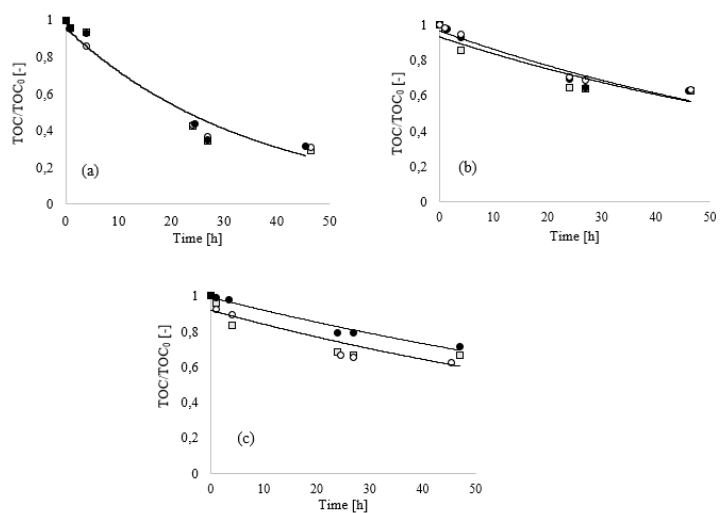
Figure 5. TOC removal trends (Blackman equation) during accelerated biodegradation tests of conditioning mixture A ( a ), B ( b ) and C ( c ) with 2.0 mL of Bacillus Clausii at different operative temperature as 20 °C ( □ ), 30 °C ( ○ ) and 40 °C ( ● ). Conditions: pH = 6 and 0.10% as conditioning mixture dosage.